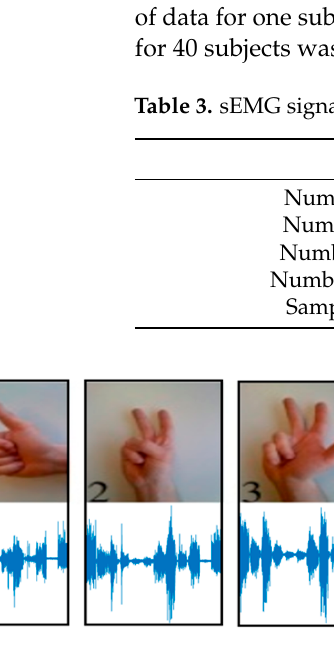
Figure 11. Seven hand motions of Ninapro DB2.